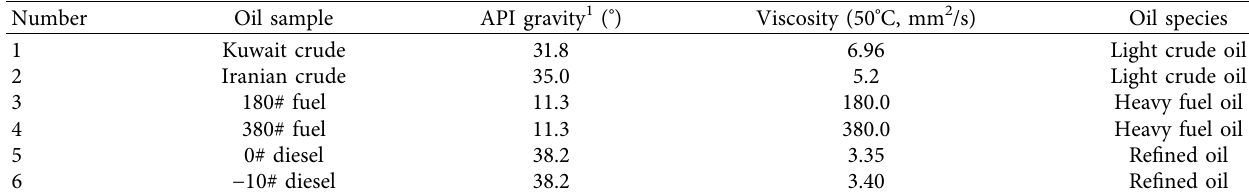
Table 1: Characteristics of the tested oil